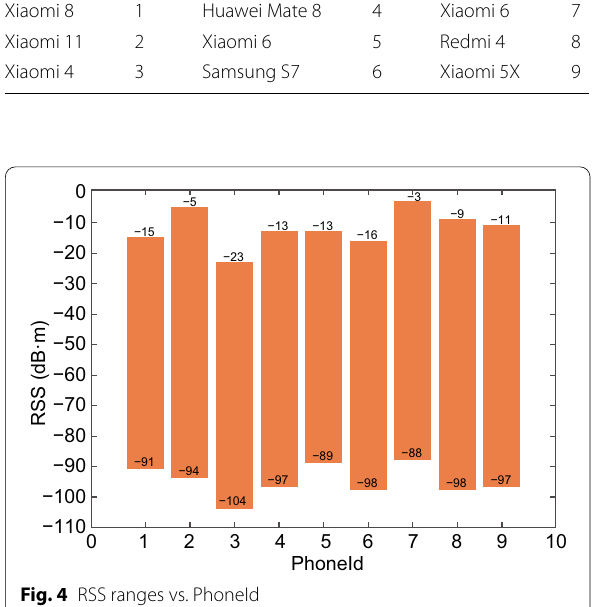
maximum value is at the top of each bar, and the mini- mum value is at the bottom. The number of RSS values larger than 20 dB m is very small. Each bar has a dif- − · ferent range of RSS values, even if smartphones are the same brand and model, e.g., both the 5th and 7th bars are the RSS values detected by Xiaomi 6. Obviously, there are differences in RSS values due to device heterogeneity. The statistics of RSS ranges with different smartphones might be helpful in solving device heterogeneity.